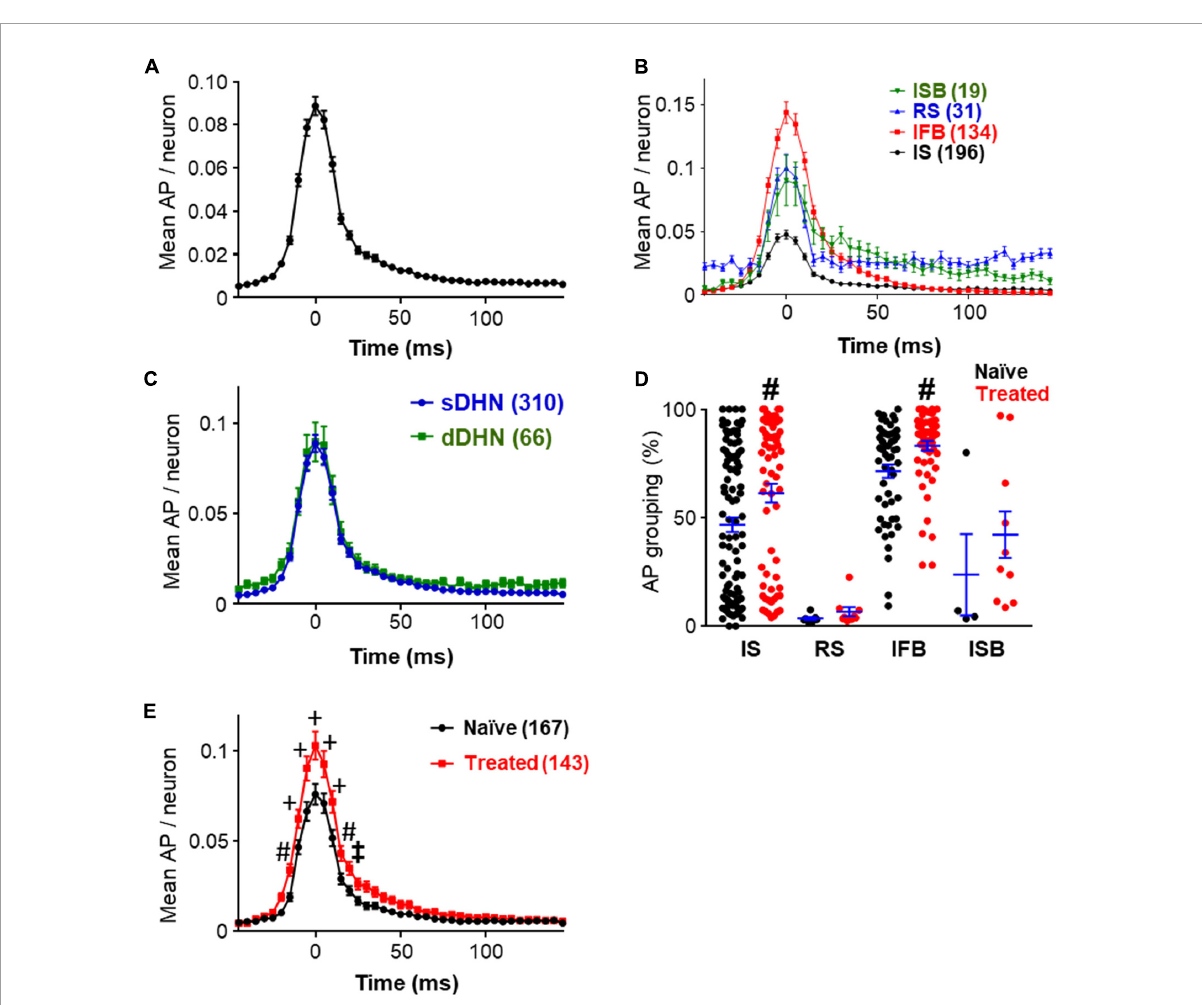
FIGURE3 Structure of bursts. (A) Shows the prototypical shape of the population bursts recorded showing the mean number of spikes that each neuron fired during the burst window in 5 ms bins. Data include all the neurons from tracks in which population burst were detected, pooling together data from naïve and treated, deep and superficial ( n = 385). (B) Graph shows the shape of the population bursts recorded from different neuronal classes as indicated (labeled by their acronyms). All neurons were included as in panel (A) , the number of neurons are indicated in brackets. Supplementary Figure 1 shows paired comparisons and detailed statistical differences. (C) Population burst forms obtained segregating neurons by depth of recording (superficial dorsal horn neurons, sDHN; deep dorsal horn neurons, dDHN; number of neurons in brackets). Data from both experimental groups were pooled together. Statistically significant differences were found for recording depth [ F (1, 15334) = 24.74; p < 0.0001] and time point [ F (40, 15334) = 104.2; p < 0.0001], but no significant interaction was found. Point by point comparisons with Sidak’s multiple comparisons were found not significant. (D) Percentage of action potentials falling within population burst windows including neurons from superficial laminae only. Neurons from different groups (naïve in black; treated in red) and neuronal classes are shown. Note that IS and IFB neurons have greater grouping values than other neurons. The grouping of IS and IFB neurons was significantly increased by treatment ( p ≤ 0.0039; Mann–Whitney test). For panels (D,E) , statistically significant differences are marked as: ‡ p < 0.05; # p < 0.01, and + p < 0.001. (E) Graph showing differences in the shape of population burst as obtained from superficial neurons in naïve and treated conditions (number of neurons indicated in brackets). A two-way ANOVA analysis shows statistically significant differences for treatment [ F (1, 308) = 7.992; p = 0.0050] and time point [ F (40, 12320) = 230.2; p < 0.0001], and a significant interaction between factors [ F (40, 12320) = 6.037; p < 0.0001]. Sidak’s multiple comparisons test following ANOVA found differences between treated and naïve groups at several time points as